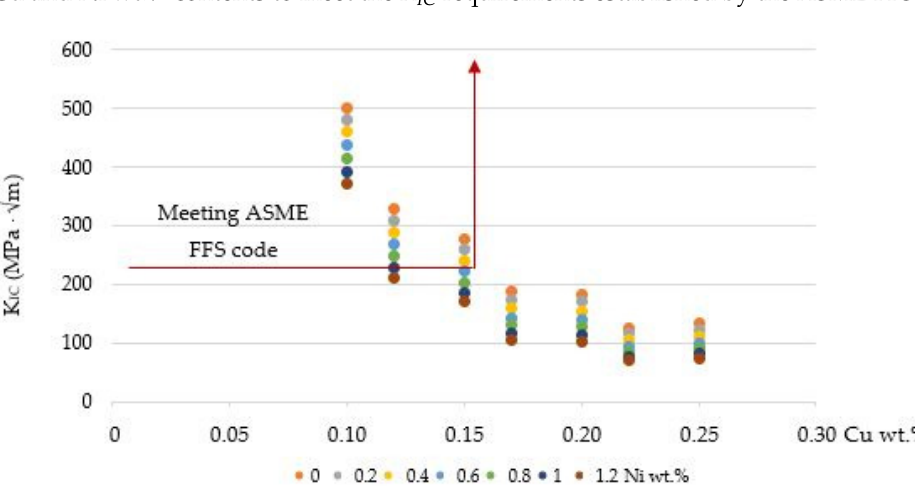
Figure 9. K IC versus Cu wt% and Ni wt%.